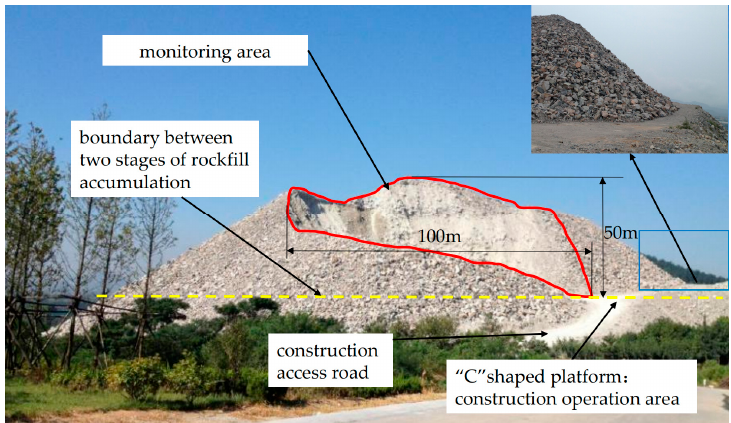
Figure 1. Overview of the rockfill. The horizontal boundary width of the red curve is about 100 m, and the maximum vertical level difference is about 50 m.